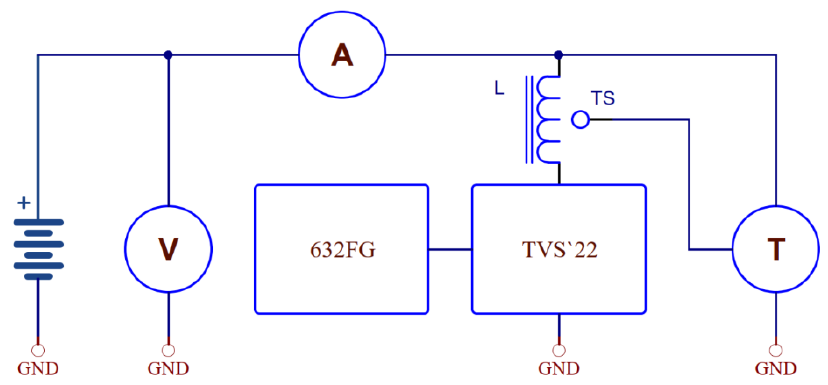
Figure 9. The realization of the electronic switch.